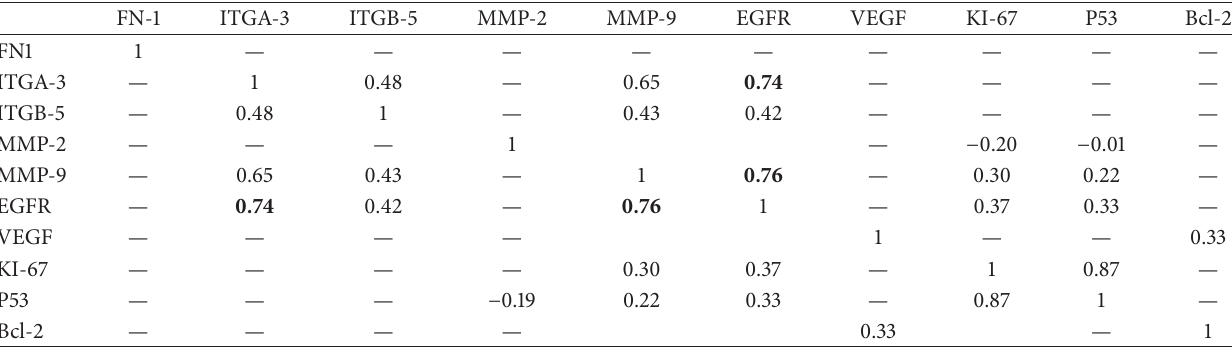
Table 11: The distribution of Spearman ( 𝑟 ) correlation coefficients, two-tailed model for significant associations ( 𝑃 < 0.05 ) between the immunohistochemical expressions of ECM genes FN-1, ITGA-3, ITGB-5, MMP-2, and MMP-9 and epithelial markers EGFR, VEGF, KI-67, P53, and Bcl-2 in CRC ( 𝑛 = 114